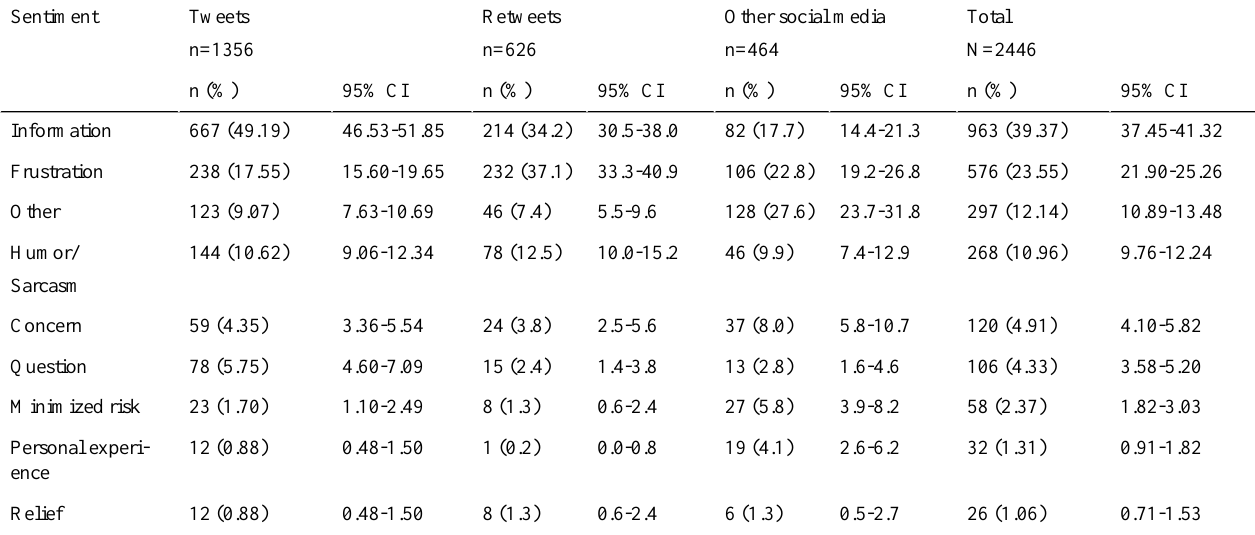
Table 6. Sentiments of coded measles-related tweets, retweets, and other social media messages.